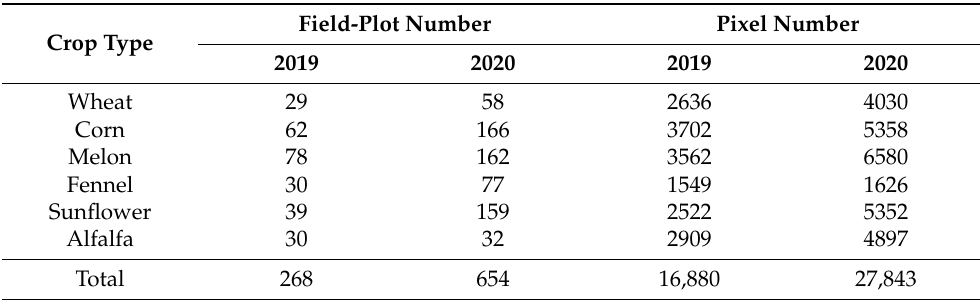
Table 1. Summary of training and verification ground samples for six crop types in the Shiyang River Basin in 2019–2020. Field-Plot Crop Type